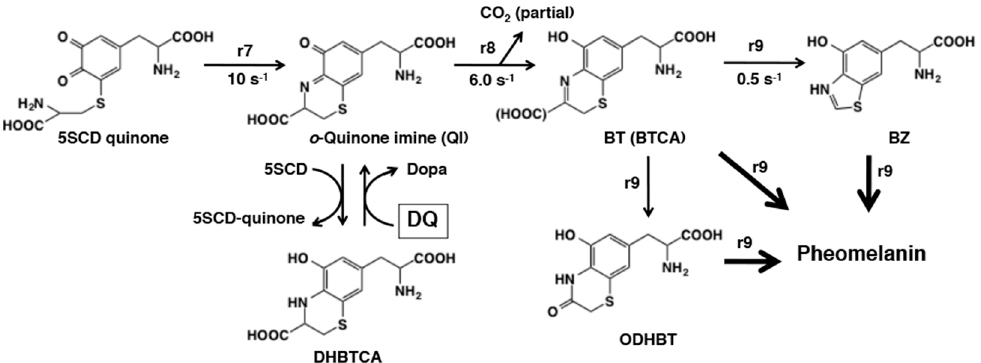
Figure 30. Kinetics of late stages of pheomelanogenesis from 5- S -cysteinyldopa (5SCD) quinone [166]. Note that dihydro-1,4-benzothiazine-3-carboxylic acid (DHBTCA) is produced via redox exchange while benzothiazine intermediates are generated by rearrangement of quinone imine intermediate (with / without decarboxylation). Rate constants are from Napolitano et al. [167]. Note that dopaquinone chemically controls pheomelanogenesis at a critical stage of DHBTCA oxidation.